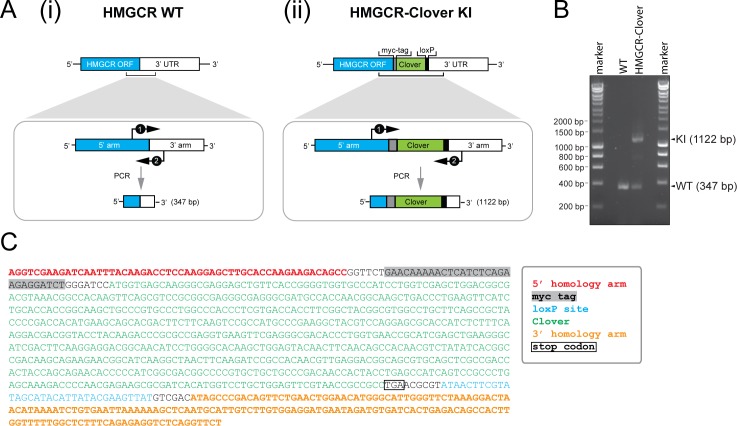
Genotyping of HMGCR-Clover knock-in cells.(A) Schematic representation of PCR amplification of the genomic locus targeted for Clover insertion in HMGCR-Clover knock-in (KI) cells. Primers (‘1’, ‘2’) specifically annealing in the 5’ and 3’ homology arms flanking the Clover gene sequence were used to amplify a region encompassing 347 bp (i) in the WT allele and 1122 bp (ii) if the Clover insert is present. (B) The PCR reaction described in (A) was performed using genomic DNA derived from parental (WT) and HMGCR-Clover knock-in HeLa cells. Amplicons derived from the unmodified (WT, 347 bp) and HMGCR-Clover knock-in allele (KI, 1122 bp) are indicated. As described in Figure 1C, HeLa HMGCR-Clover KI cells retain at least one unmodified HMGCR allele in addition to endogenously Clover-tagged HMGCR. (C) Genetic profiling of the HMGCR-Clover KI locus in HMGCR-Clover HeLa cells. The longer 1122 bp PCR product, obtained as described in (A), was isolated by agarose gel electrophoresis and confirmed by Sanger sequencing.